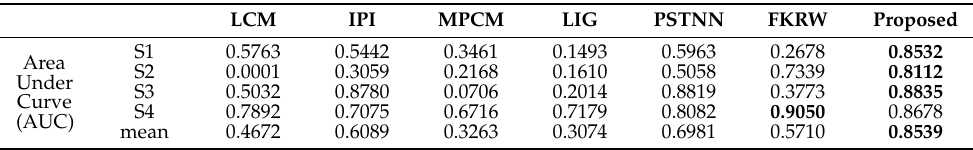
Table 2. The comparison of the AUC among different methods.